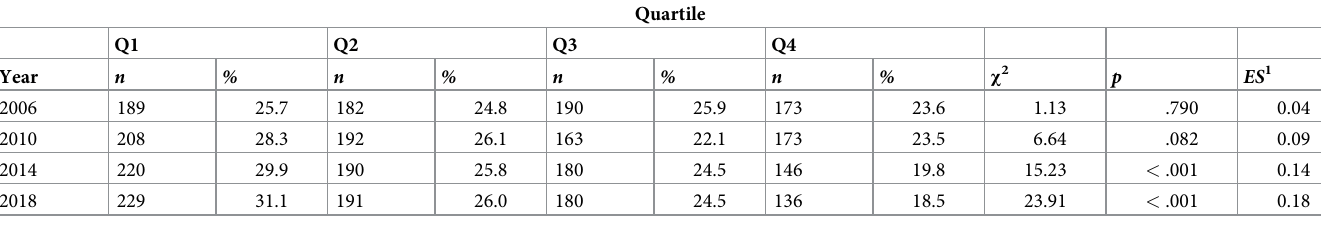
Table 6. Distribution of birth dates in male soccer players participating in the senior world cup 2006–2018.